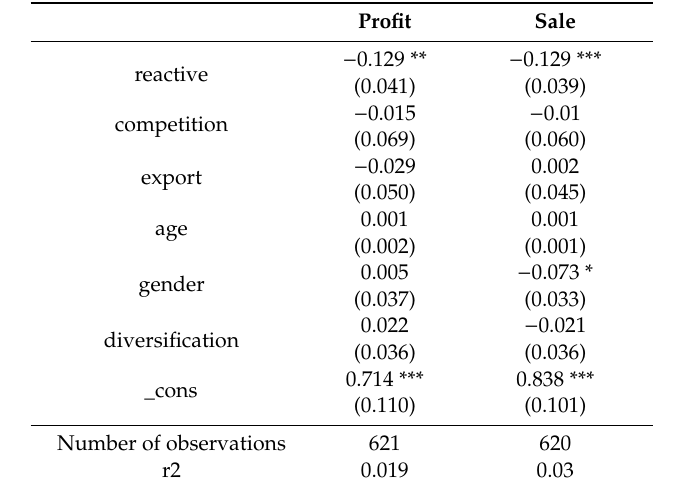
Table 5. Regression results of reactive technological innovation (hypothesis